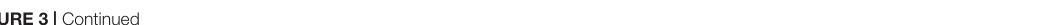
Frontiers in Cell and Developmental Biology |